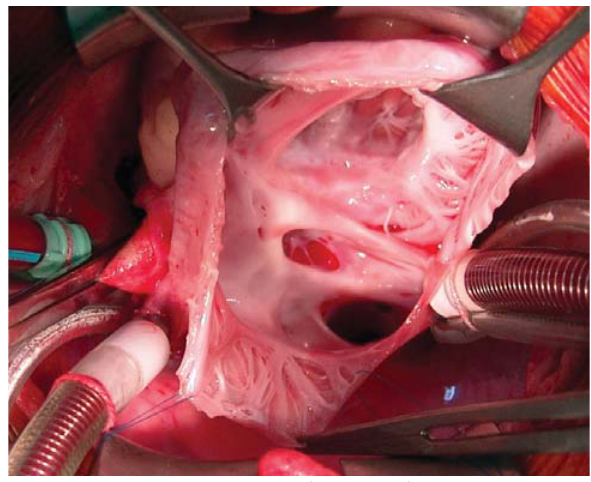
Fig. 2 – Aspecto intra-operatório com átrio direito aberto longitudinalmente, septo interatrial íntegro e veias pulmonares direitas conectadas ao átrio direito